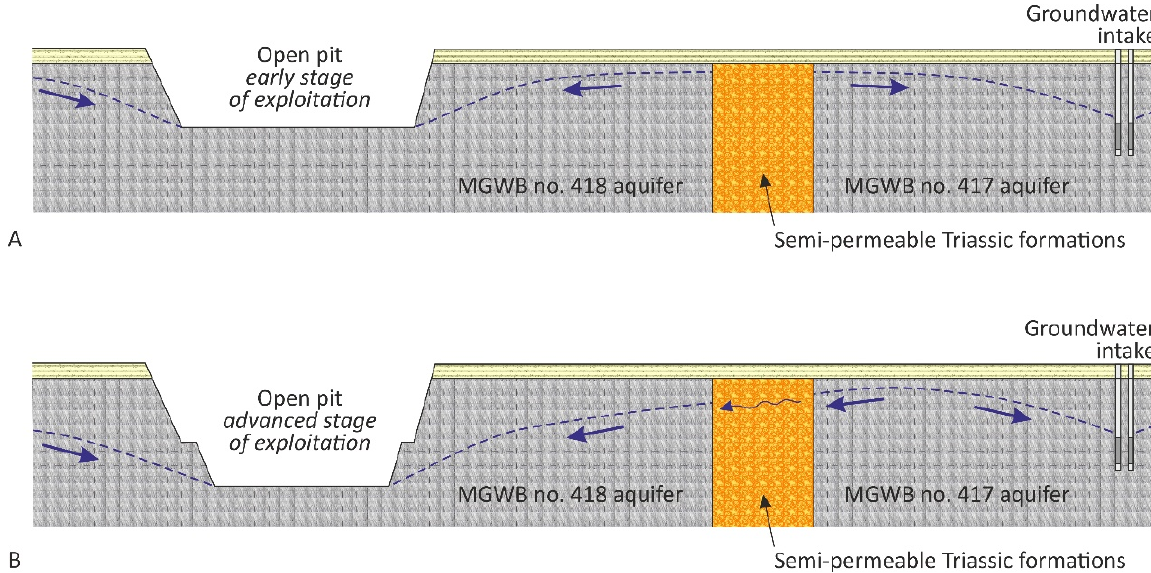
Figure 4. A schematic cross-section diagram of hydraulic connections between the considered hydrogeological structures (not to scale): early ( A ) and advanced ( B ) stages of open-pit exploitation. Blue dashed line—groundwater table; blue arrows—general directions of groundwater flow.